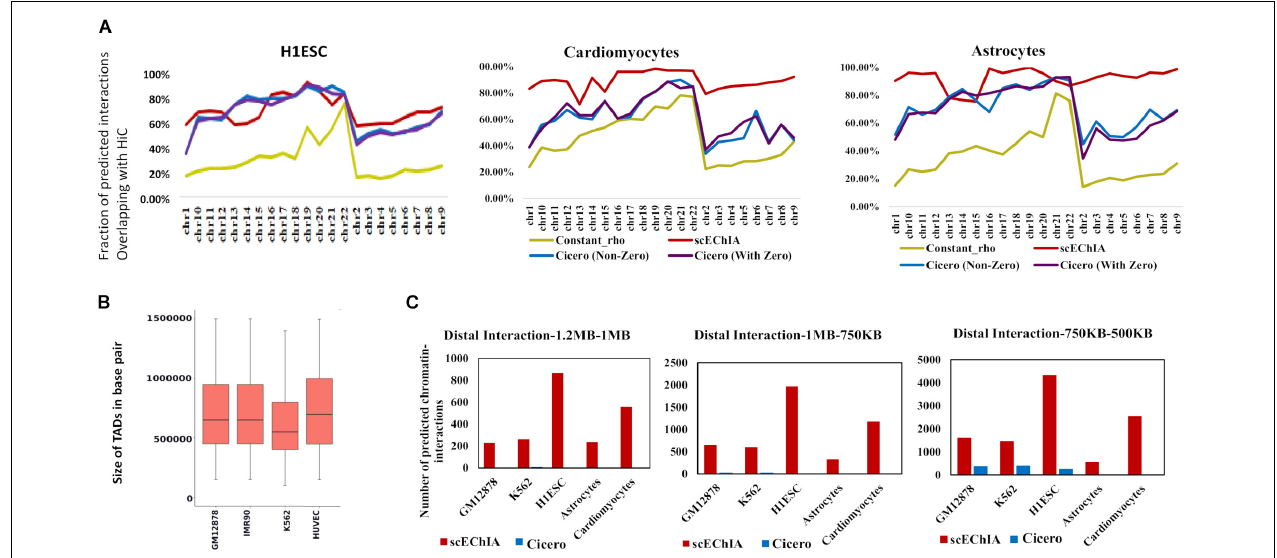
FIGURE 1 | Evaluation of accuracy and sensitivity of chromatin-interaction prediction. (A) Accuracy of prediction of chromatin-interaction using single-cell open chromatin profile is shown for three methods: Glasso used with constant regularization parameter (constant_rho), Cicero, and scEChIA. For Cicero, two results are shown; one without taking predicted interaction with zero scores and the other comprising all interactions. Accuracy was measured as the fraction of predicted chromatin interactions, which overlapped with enriched interactions (top 60,000 in each chromosome) in the HiC profile of the respective cell (see Supplementary Material ). (B) The sizes of topologically associated domains (TADs) in different types of human cells. The TAD boundaries are made available by Liu et al. (2019) at (http://dna.cs.miami.edu/TADKB/). The median TAD size is more than 500 kbp. (C) The sensitivity of prediction of distal chromatin-interaction is shown here for different ranges of the distance between interacting genomic loci. scEChIA breaks the barrier of fixed-distance criteria and is 1,000 times more sensitive in predicting long-range chromatin-interactions ( > 500